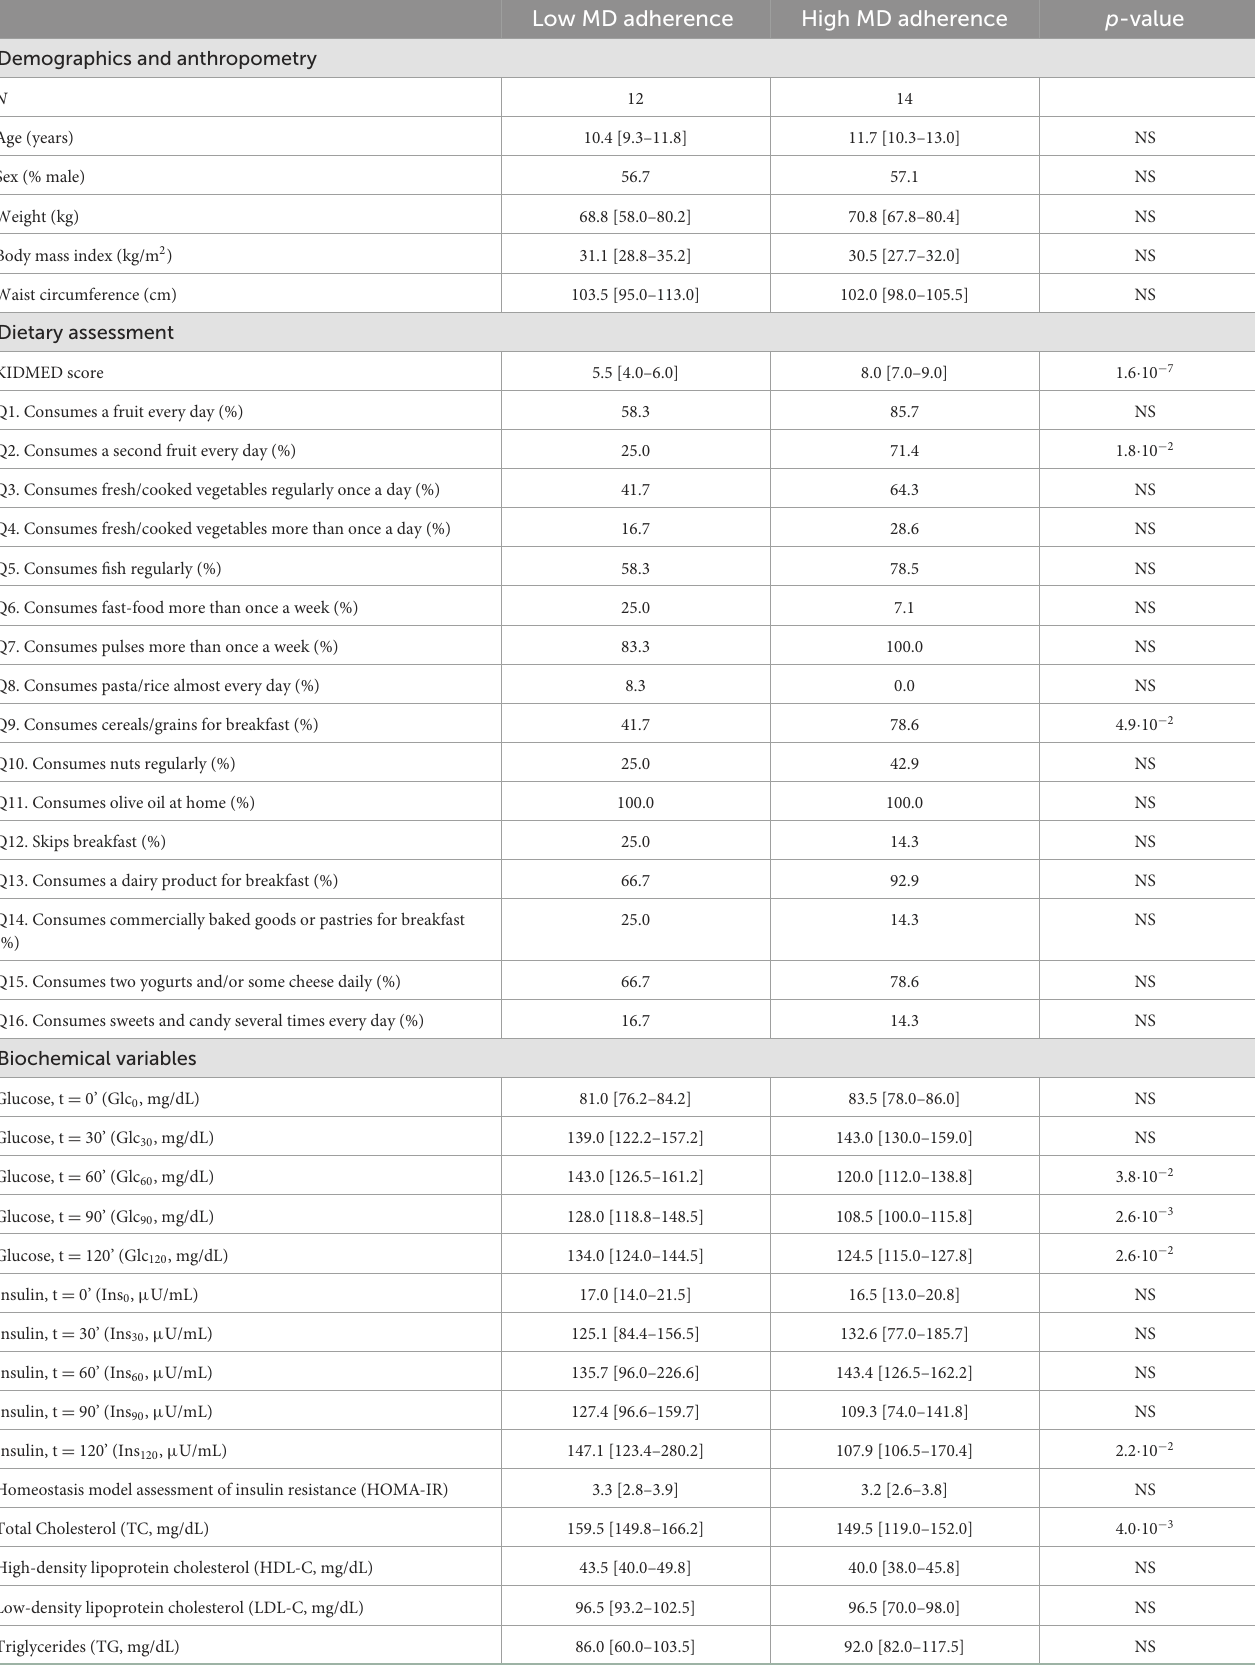
TABLE 1 Demographic, anthropometric, dietary, and biochemical characterization of the study